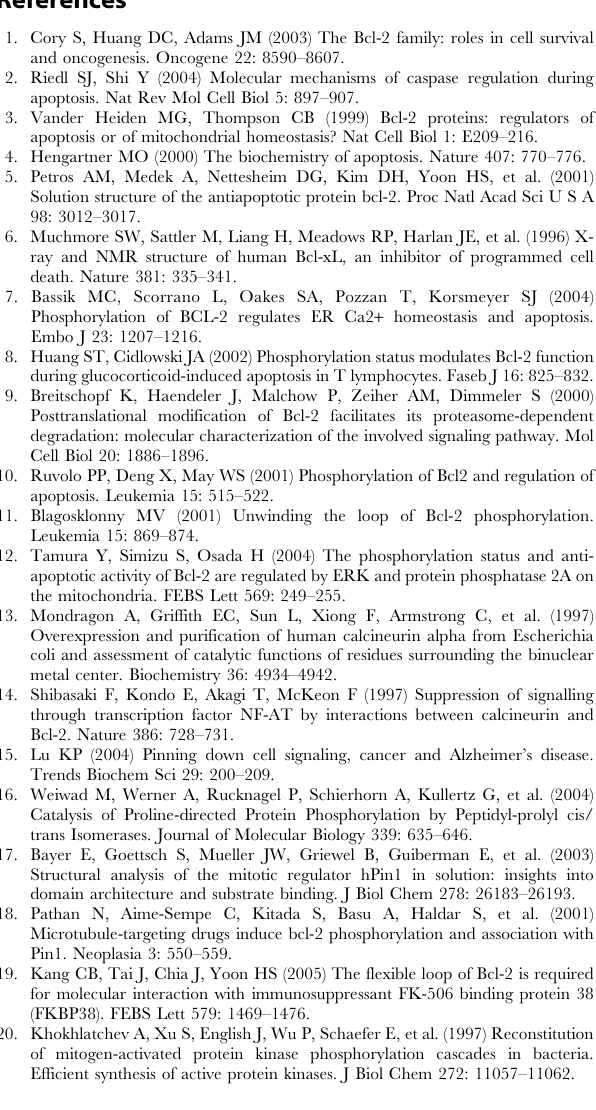
Table S1 Resonance assignment of peptides S87 and